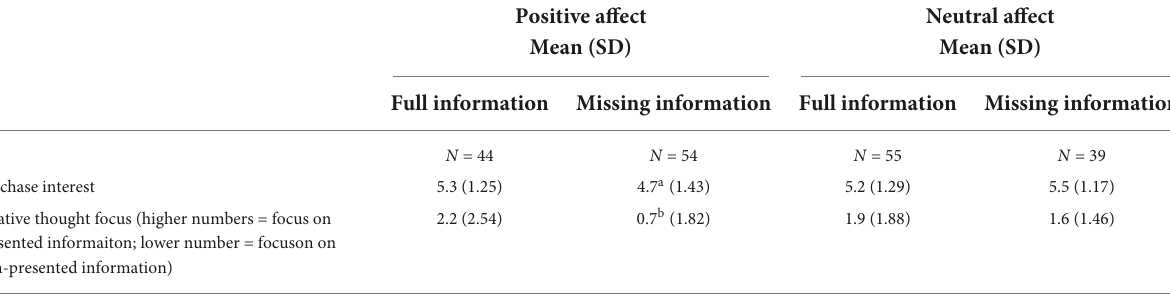
TABLE 4 Experiment 4: Product evaluation and relative thought focus as a function of positive affect, task type, and information